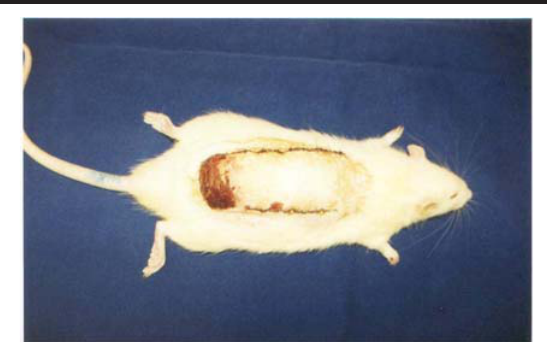
FIGURE 5 - Necrotic tissue (control